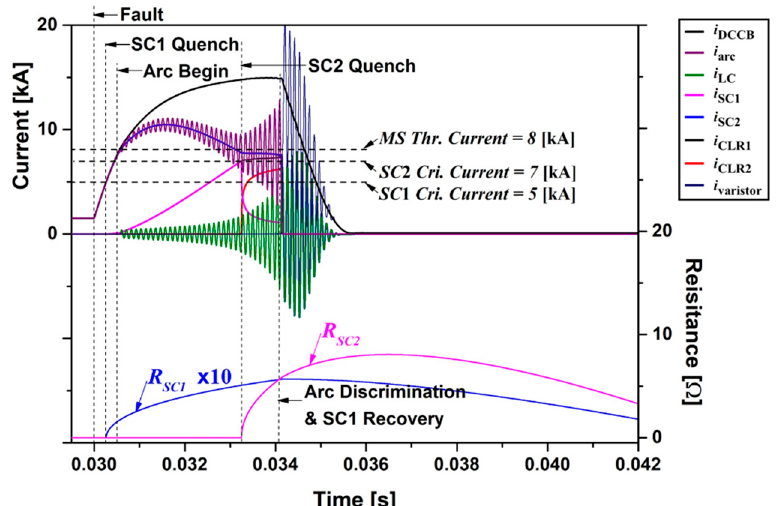
Figure 3. The waveform of DCCB current ( i DCCB ), Arc current ( i arc ), LC circuit current ( i LC ), HTSC1 current ( i SC1 ), HTSC2 current ( i SC2 ), CLR1 current ( i CLR1 ), CLR2 current ( i CLR2 ) and varistor current ( i varistor ), 10 times resistance of HTSC1 ( R SC1 ), and resistance of HTSC2 ( R SC2 ); impedance setting CLR1: Inductance 2 (mH), CLR2: Resistance 1.0 ( Ω ).